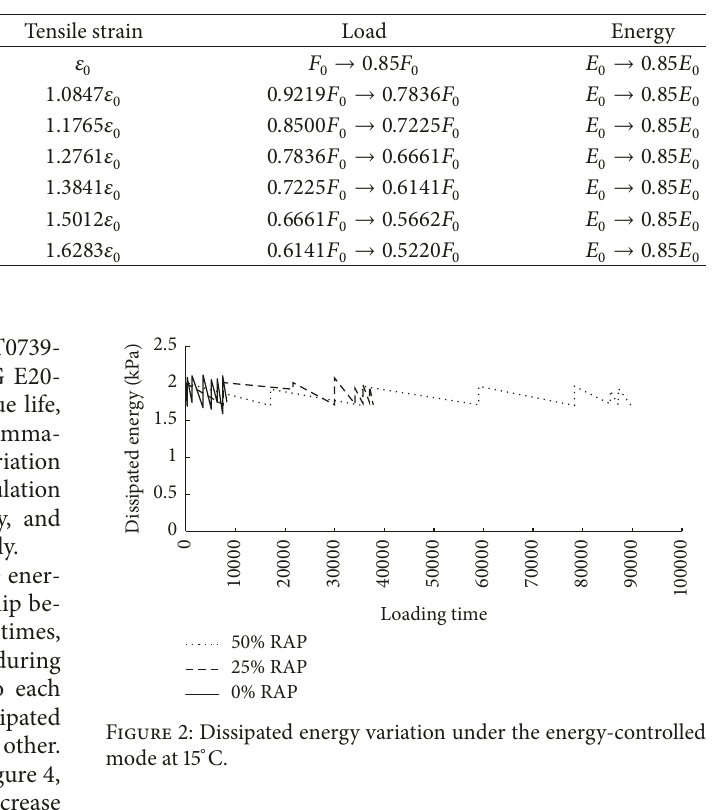
Table 3: Parameter-controlled process under the energy-controlled mode.